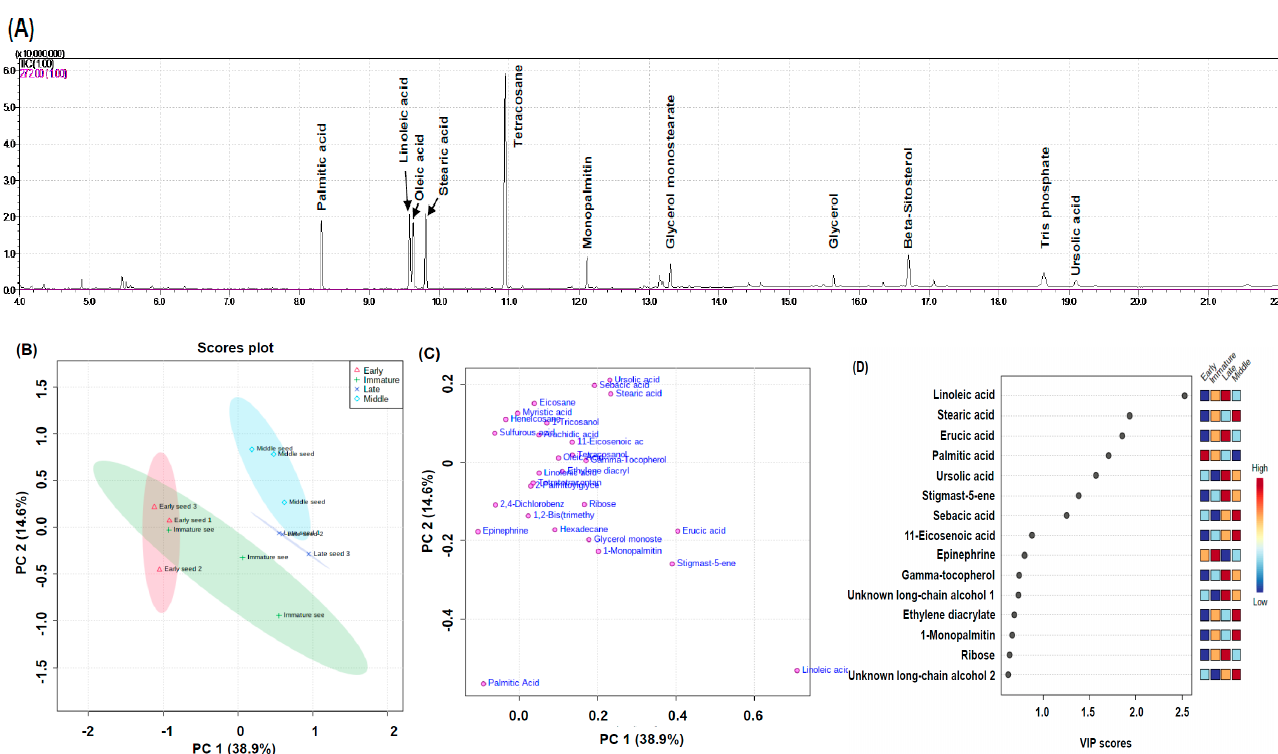
Figure 7. Chromatograms of lipid-soluble compound ( A ) from rose hip seeds by GC-MS analysis. Partial least squares- discriminant analysis (PLS-DA) score plot ( B ), loading plot ( C ), and variable importance in projection (VIP) scores ( D ).